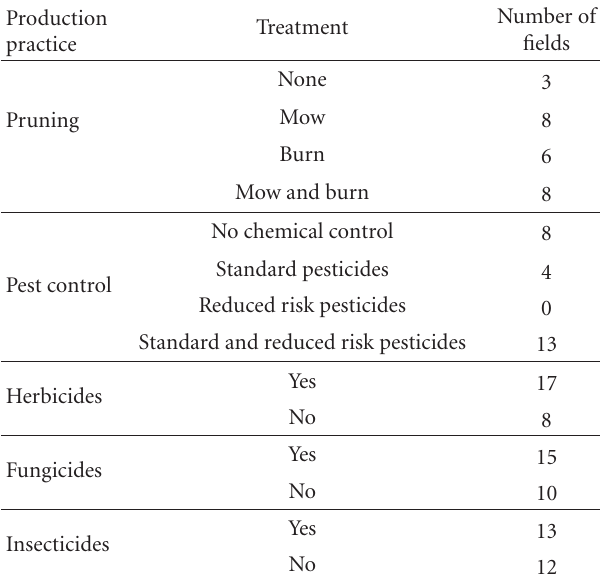
Table 1: Production practices associated with the 25 sampled lowbush blueberry fields, 2009-2010. The field was given a score for each production practice based on the treatment the field received for one complete growing cycle (2 calendar years) ending with the bumblebee collection year. These practices were included in the linear model to examine field characteristics and Nosema